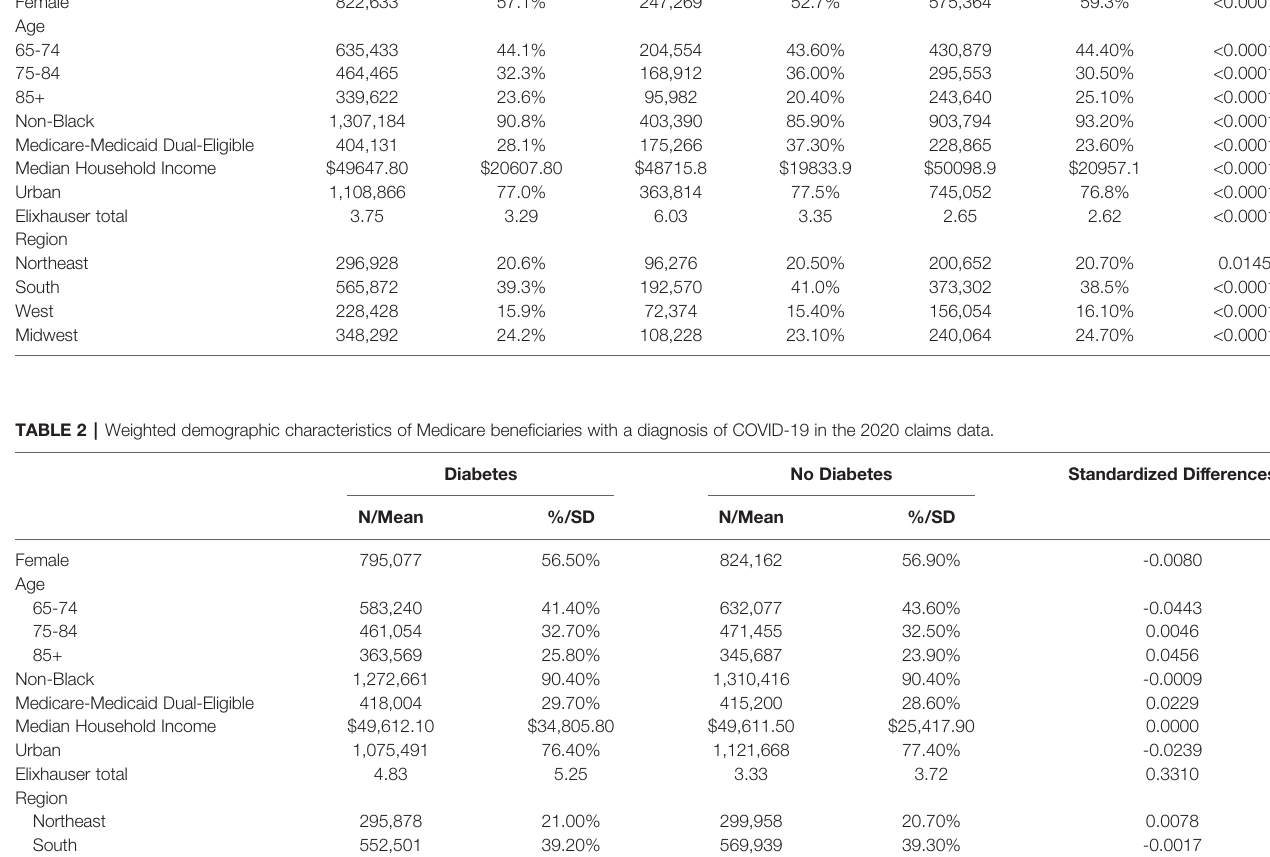
TABLE 1 | Unweighted demographic characteristics of Medicare bene fi ciaries with a diagnosis of Covid-19 in the 2020 claims data.